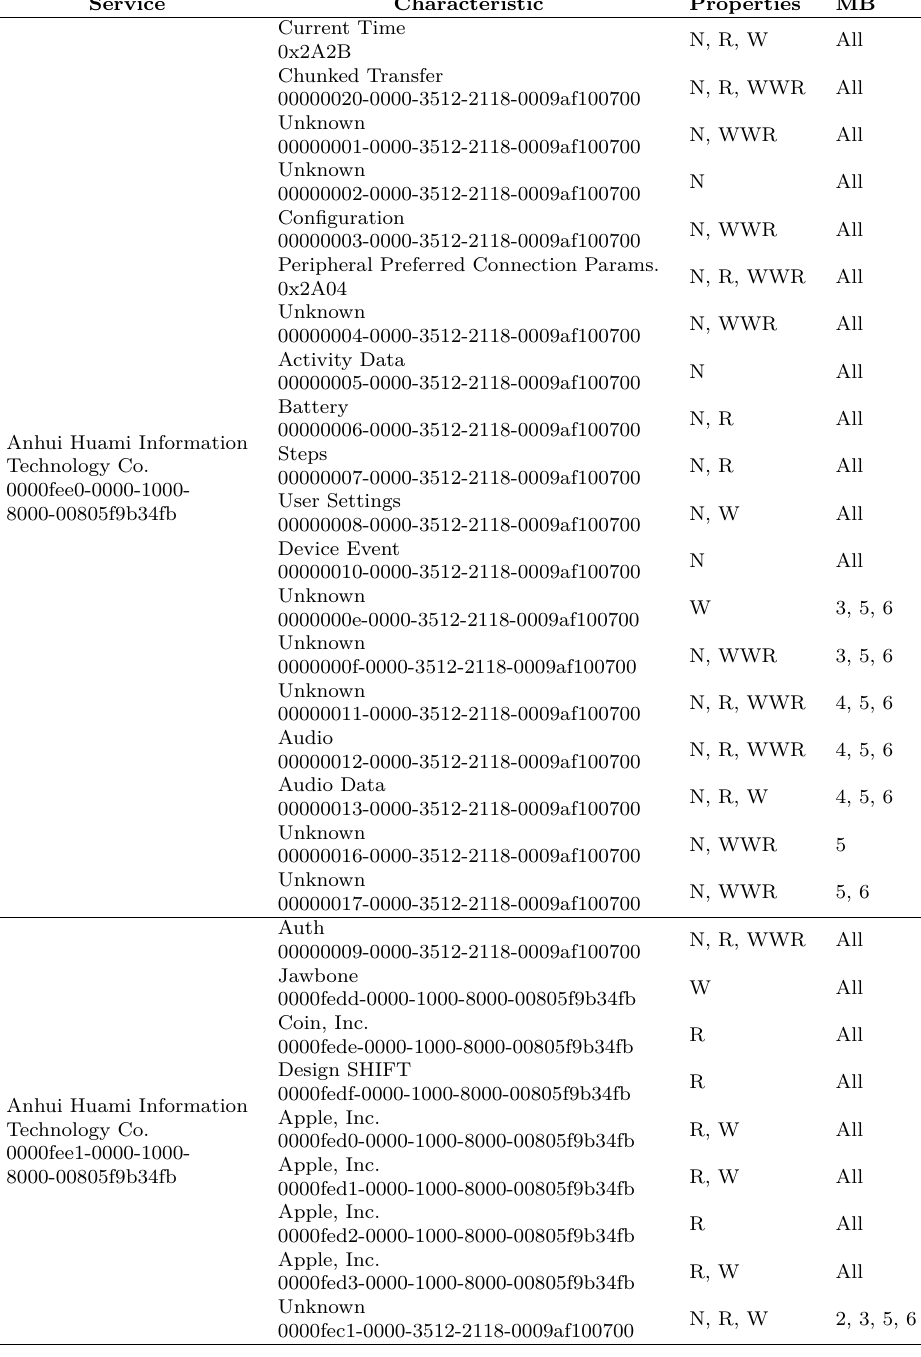
Table 7: Huami services and characteristics exposed by every Mi Band GATT server. The first column shows the service name, and the second the characteristic name. The third column indicates the characteristic’s access control policy (R = read, W = write, WWR = write without response, N = notify, I = indicate). The last column indicates which Mi Band supports the current